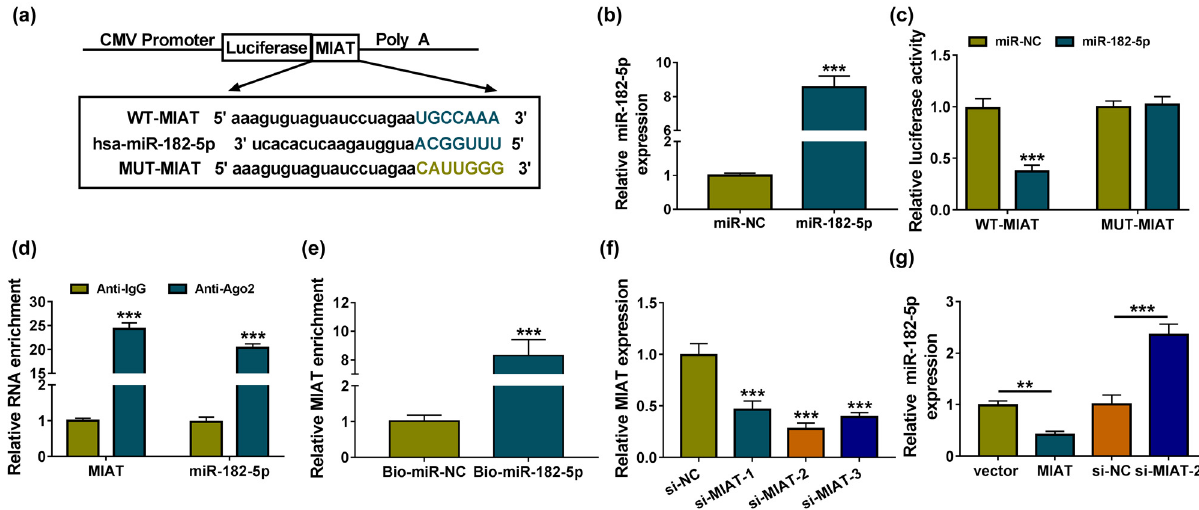
Figure 3: MIAT directly interacted with miR - 182 - 5p. ( a ) The binding sites between MIAT and miR - 182 - 5p were analyzed via online miRcode. ( b ) The overexpression e ffi ciency of miR - 182 - 5p mimic was assayed through RT - qPCR. ( c – e ) Dual - luciferase reporter assay ( c ) , RIP ( d ) , and RNA pull - down assay ( e ) were conducted to manifest the con fi rmation between MIAT and miR - 182 - 5p. ( f ) MIAT detection was carried out using RT - qPCR after transfection of si - NC, si - MIAT - 1, si - MIAT - 2, or si - MIAT - 3. ( g ) The e ff ects of MIAT and si - MIAT - 2 on miR - 182 - 5p were measured by RT - qPCR, with vector and si - NC as the respective control. ** P < 0.01, *** P <